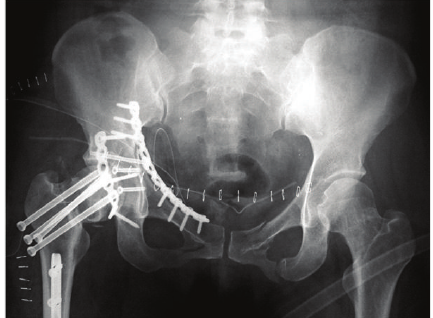
Figure 4: A postoperative radiograph of the acetabulum. Anterior and posterior plate fixation is